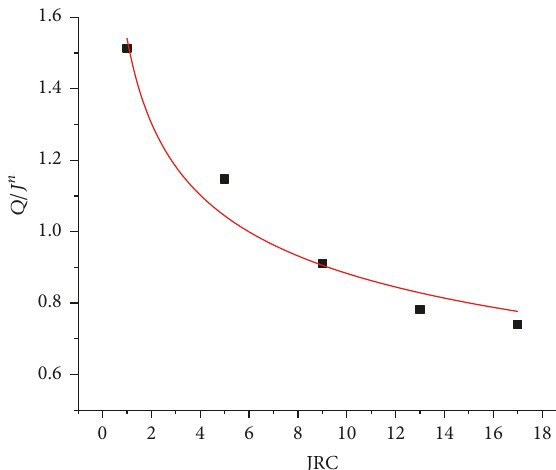
Figure 9: Relationship curves between 𝑄/𝐽 𝑛 and fracture roughness coefficient.